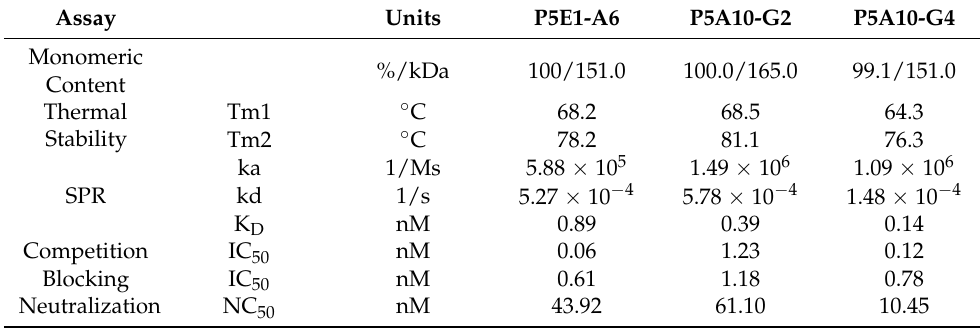
Table 3. Summary of characterization of P5E1-A6 and P5A10-G2 and